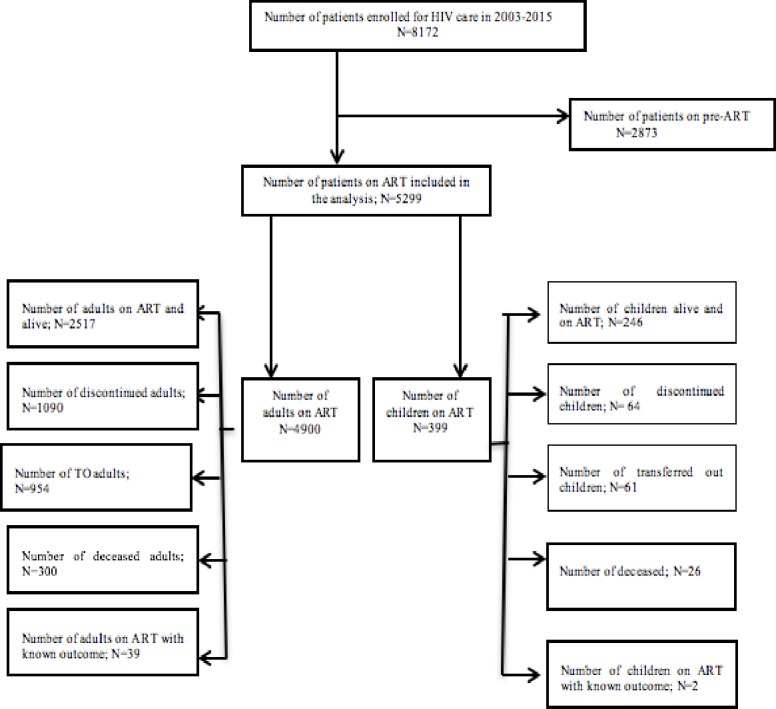
Schematic presentation of data extraction of HIV infected patients on ART in 2003–15 in Jimma University Teaching Hospital, Southwest Ethiopia—This figure shows the data extraction flowchart.